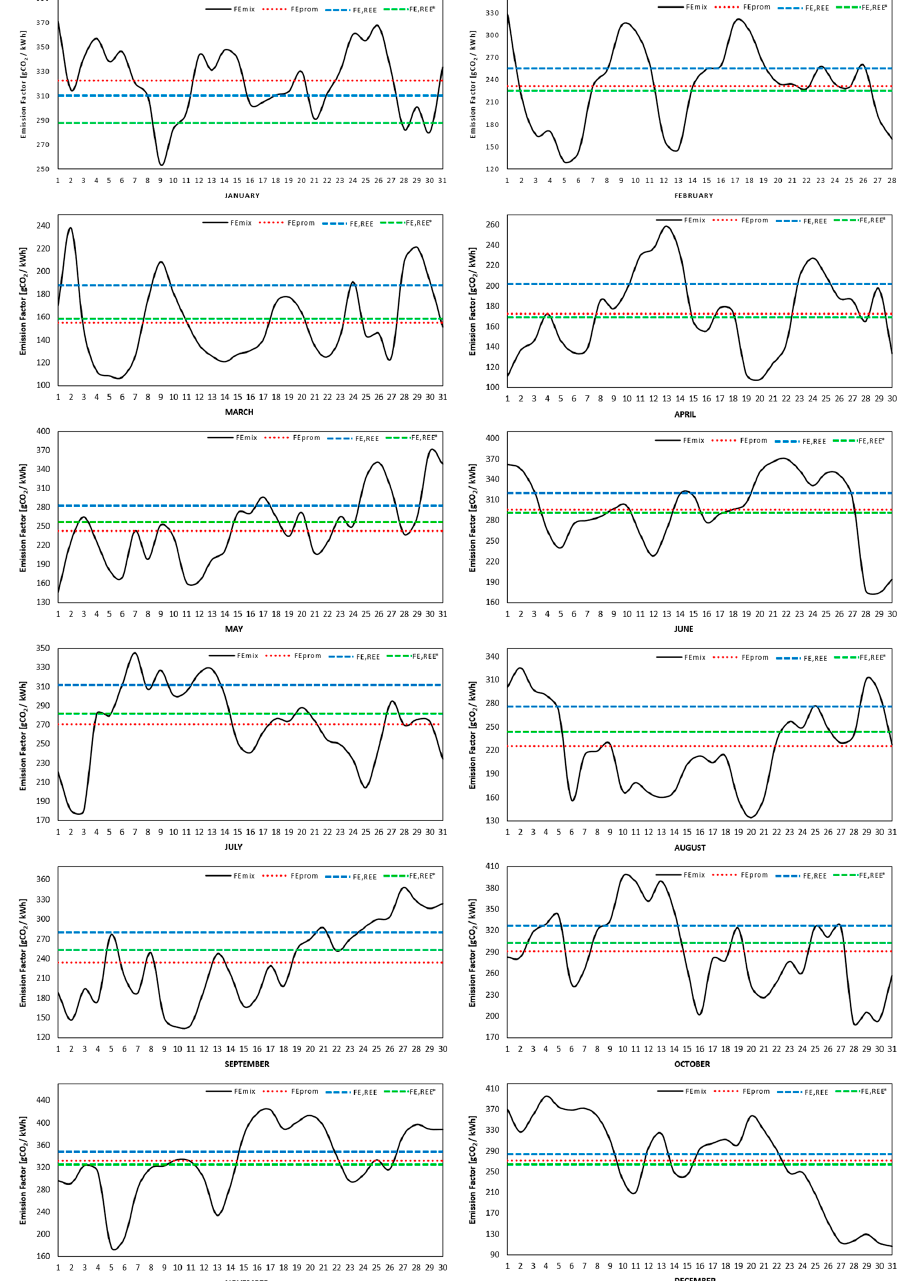
Figure 17. CO 2 emissions factors of the Spanish electricity mix for the year 2017.